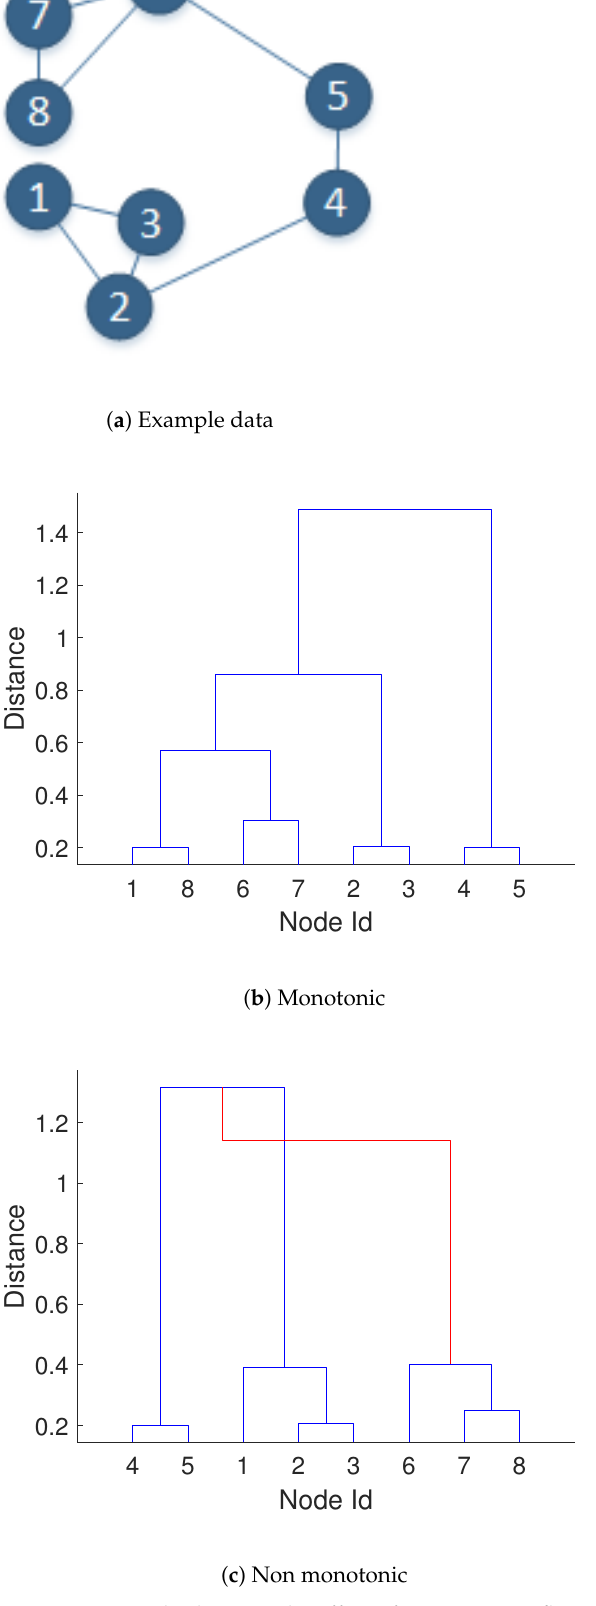
Figure 3. Example showing the effect of constraints influencing monotonicity of the dendrogram. ( a ) Example data with links defining the constraints; ( b ) dendrogram obtained without any constraints on graph topology; ( c ) dendrogram obtained when clustering preserving graph